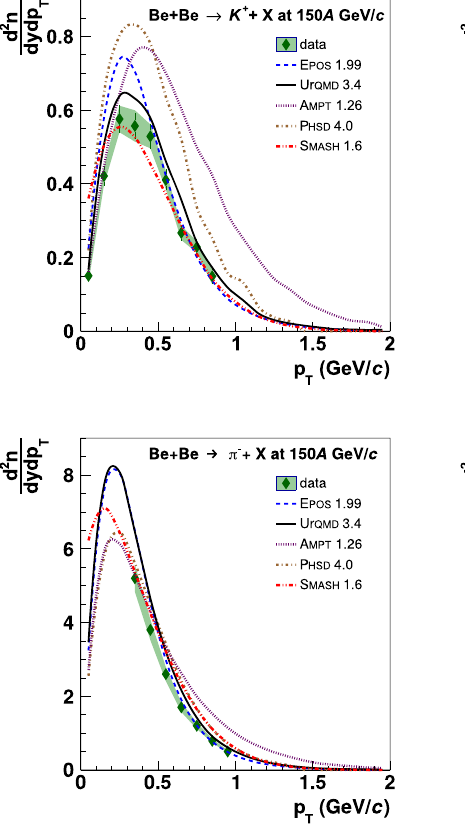
dashed line), U r qmd 3.4 (black solid line), Ampt 1.26 (violet dotted line), Phsd 4.0 (brown dashed-dotted line) and Smash 1.6 (red dashed- double dotted